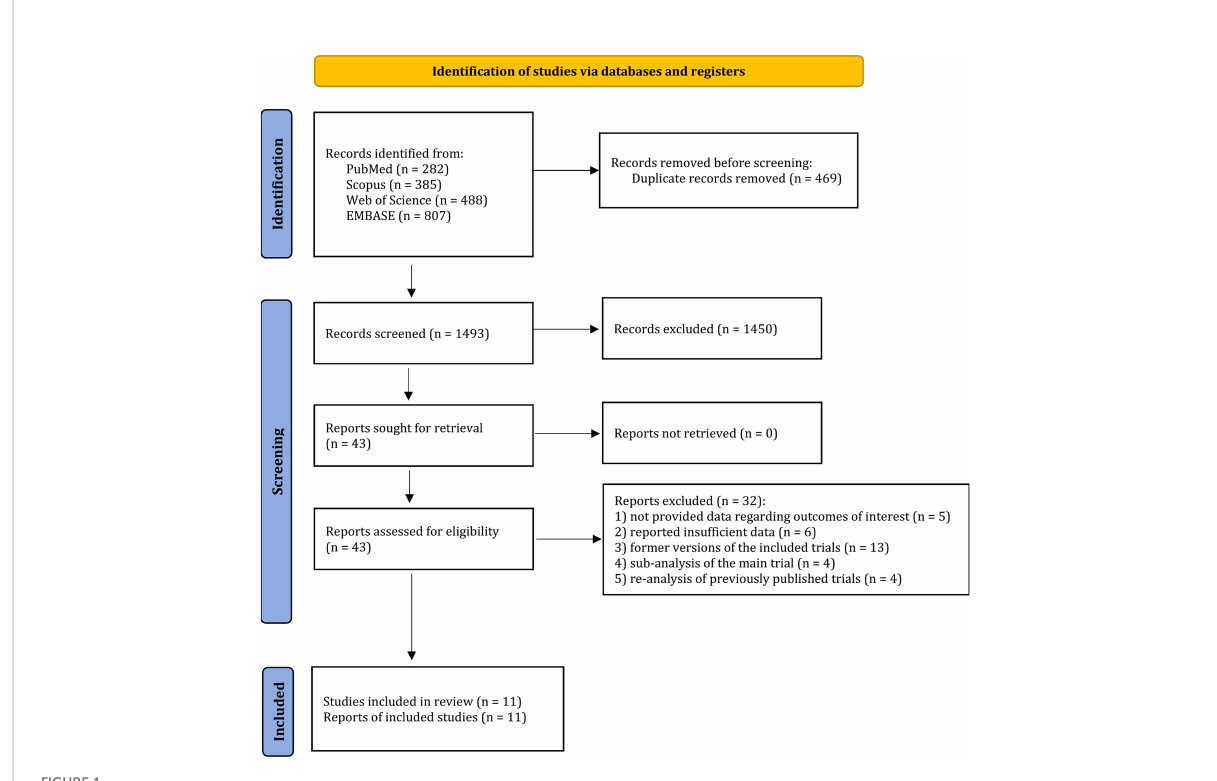
FIGURE 1 Study selection process of the